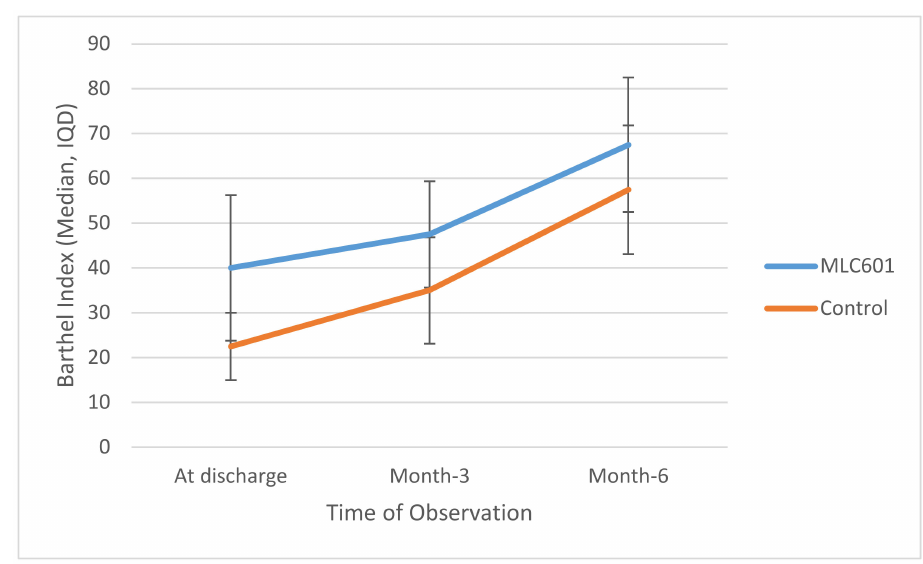
Figure 2. Trajectories of BI over time between